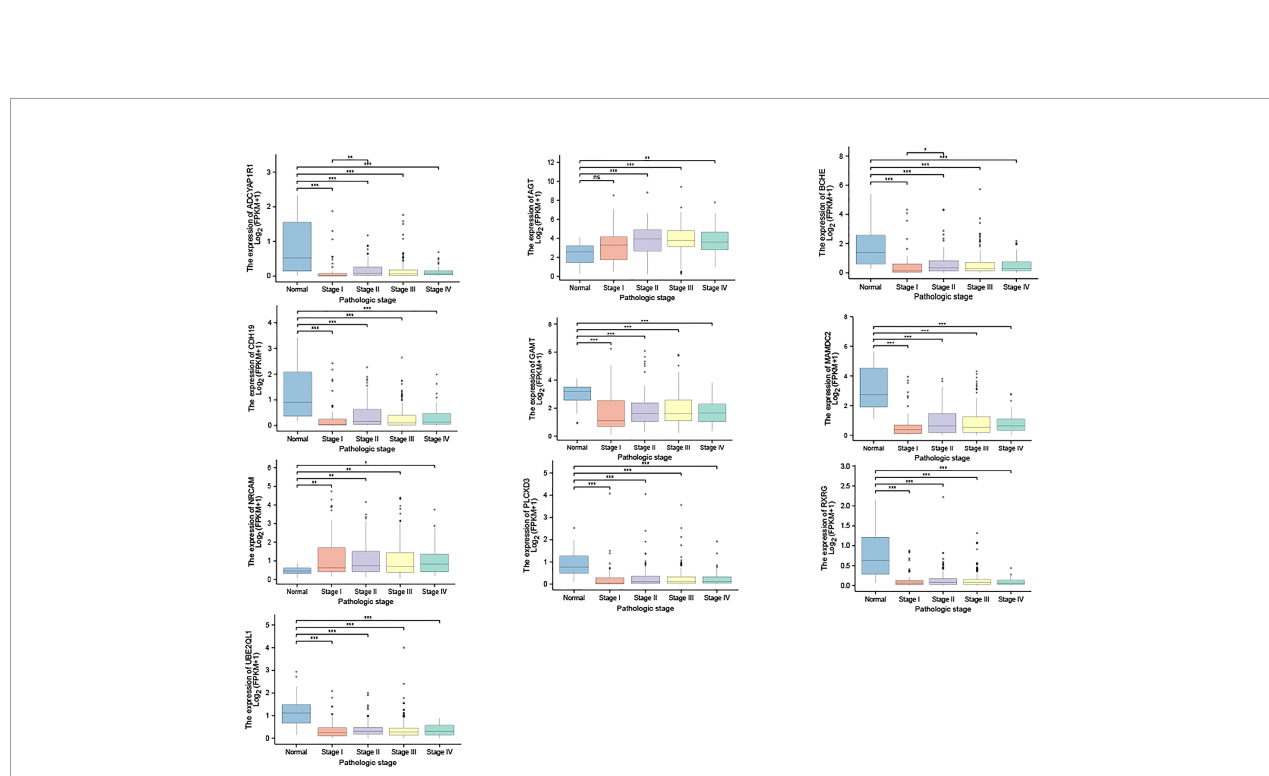
FIGURE 6 | Expression of 10 genes in diverse stages of gastric cancer. *p < 0.05; **p < 0.01; ***p < 0.001; ns, non signi fi cant.